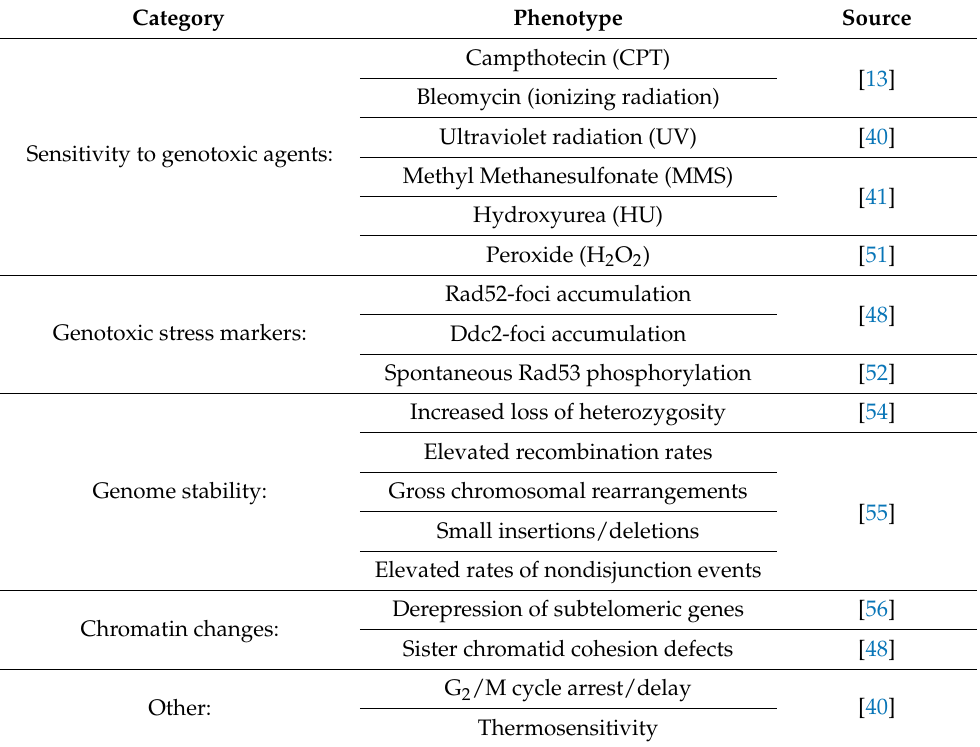
Table 1. Phenotypes of ∆ hst3 ∆ hst4